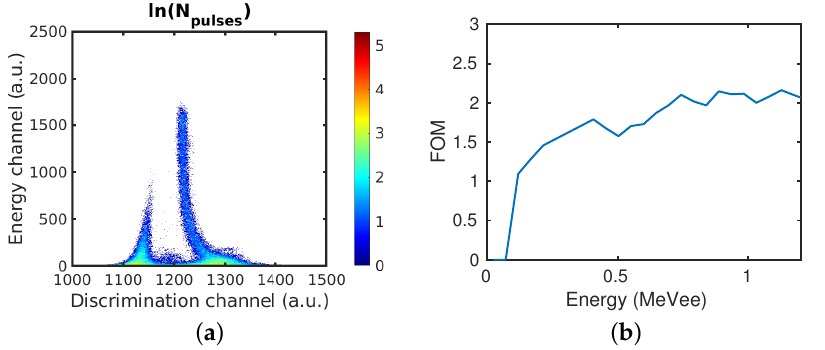
Figure 1. ( a ) Two-parameter histogram of the DT reaction with an energy of E n = 14MeV detected using a 1 inch PYR5/DIPN scintillator. ( b ) FOM for the same measurement.